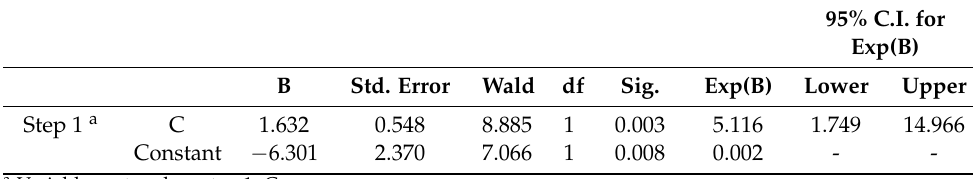
Table 13. Compatibility: regression analysis for PaaS.